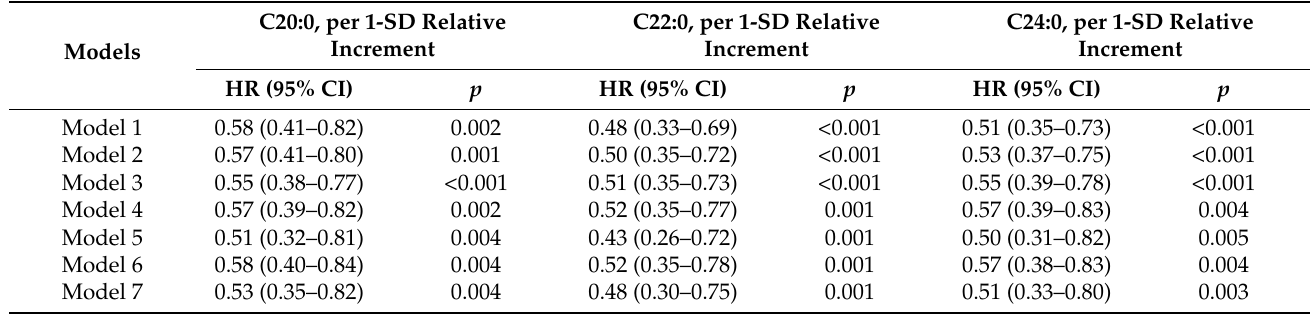
Table 4. Prospective analysis of standardized circulating VLSFA with infectious disease mortality in KTR.